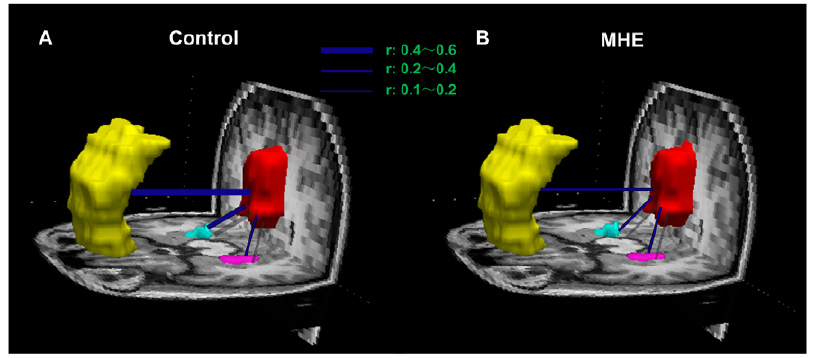
Figure 3. Functional connectivity within the DMN in healthy control and MHE patient groups. Averaged temporal correlation coefficient r (Blue) across all subjects in the healthy control group (A) and in the MHE patient group (B). Compared with healthy controls, MHE patients show decreased temporal correlation coefficients between the PCC/PCUN and the MPFC, as well as between the PCC/PCUN and the left PHG. MPFC is color-coded yellow, PCC/PCUN color-coded red, the left PHG color-coded pink, the right PHG color-coded cyan. DMN=default mode network; MHE=minimal hepatic encephalopathy. PCC/PCUN=posterior cingulate cortex/precuneus; MPFC=medial prefrontal cortex; PHG=parahippocampal